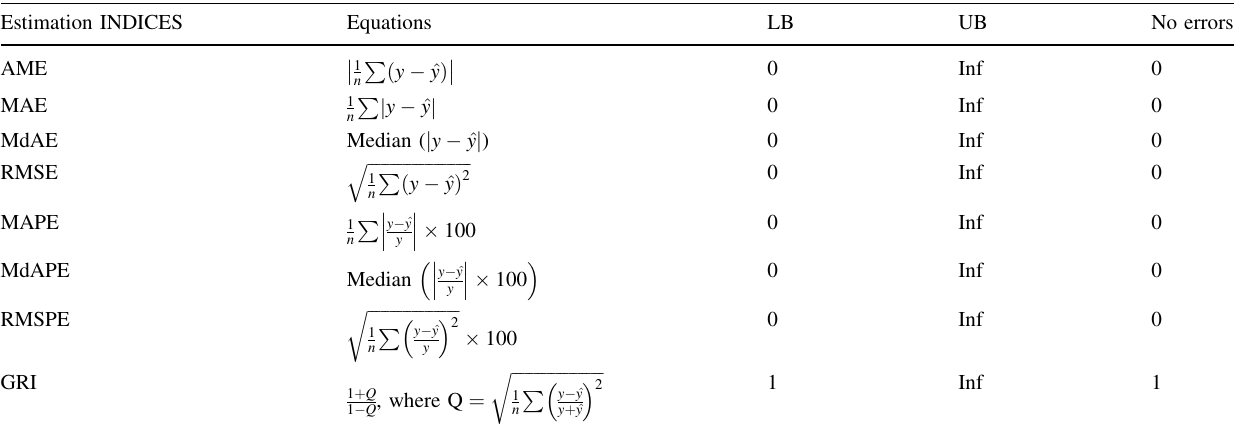
Table 2 Eight estimation methods for evaluation of modeling accuracy Estimation INDICES